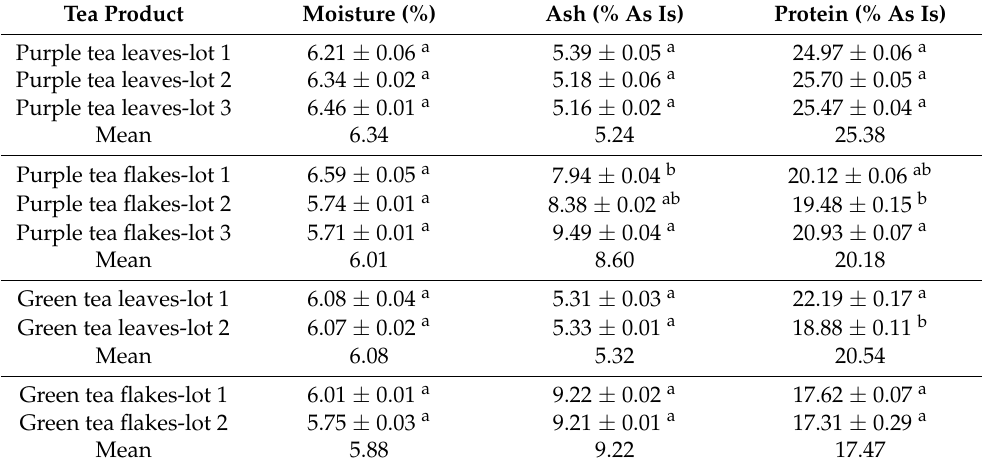
Table 1. Moisture, total ash and protein content of purple and green tea leaves and flakes x